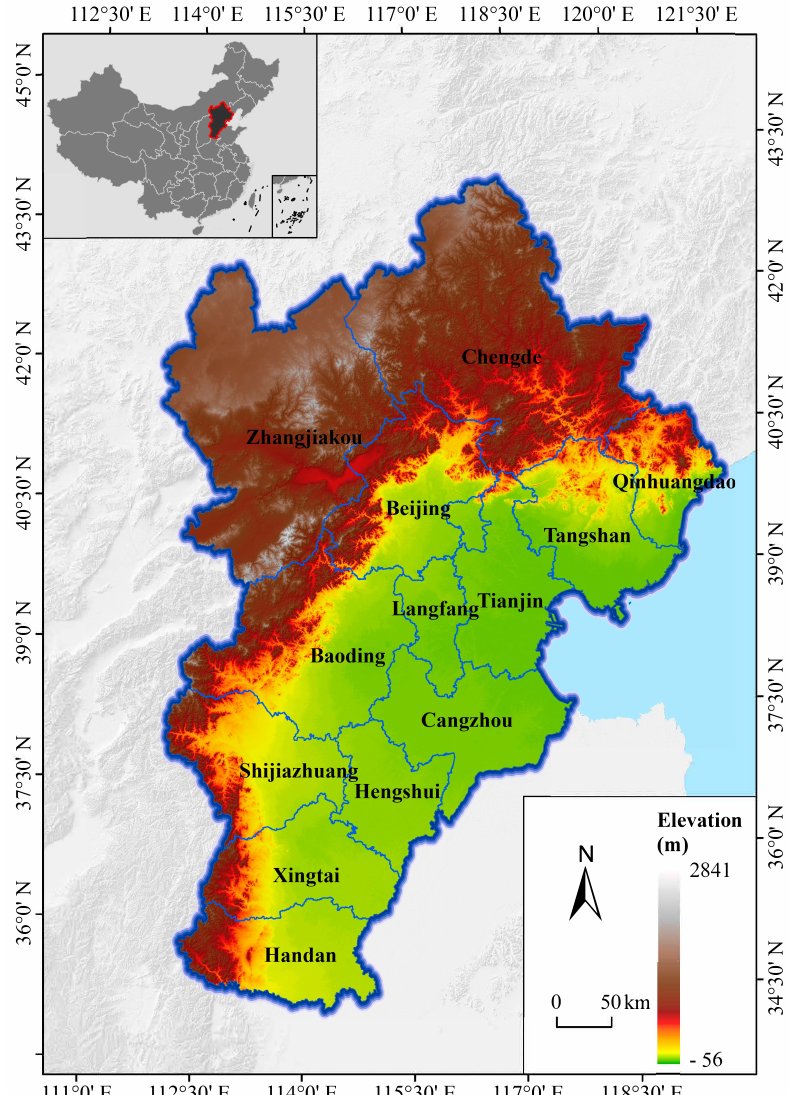
Figure 1. Geographic distribution of the terrain and cities in Beijing–Tianjin–Hebei